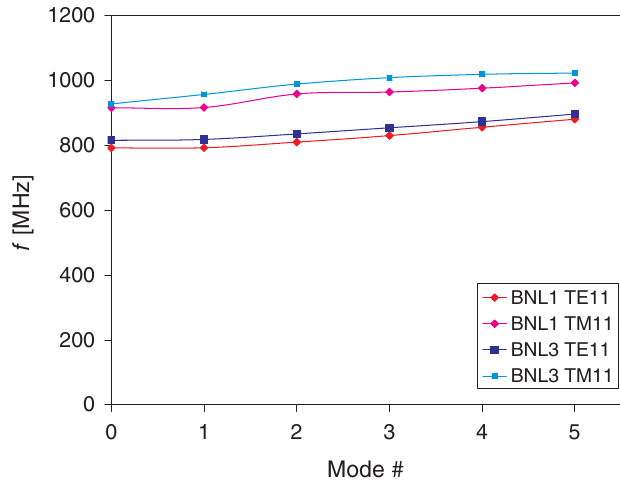
FIG. 12. Brillouin diagram for the BNL1 and BNL3 cavity models.